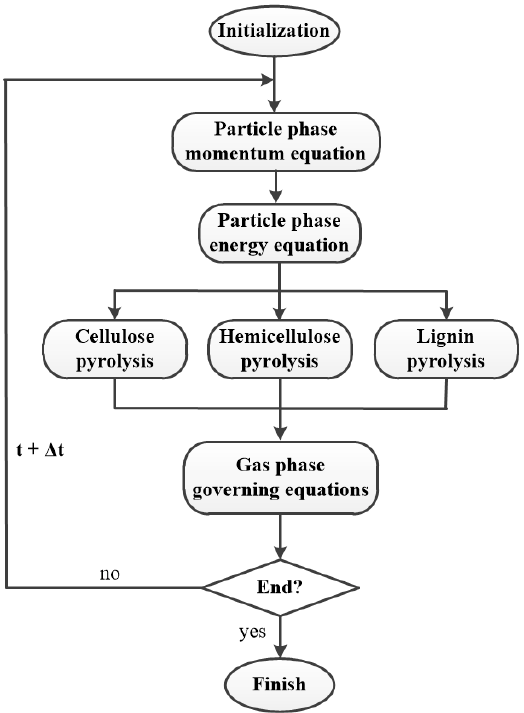
Figure 1. Flow chart of the CFD-DEM algorithm with a multistep kinetic scheme.